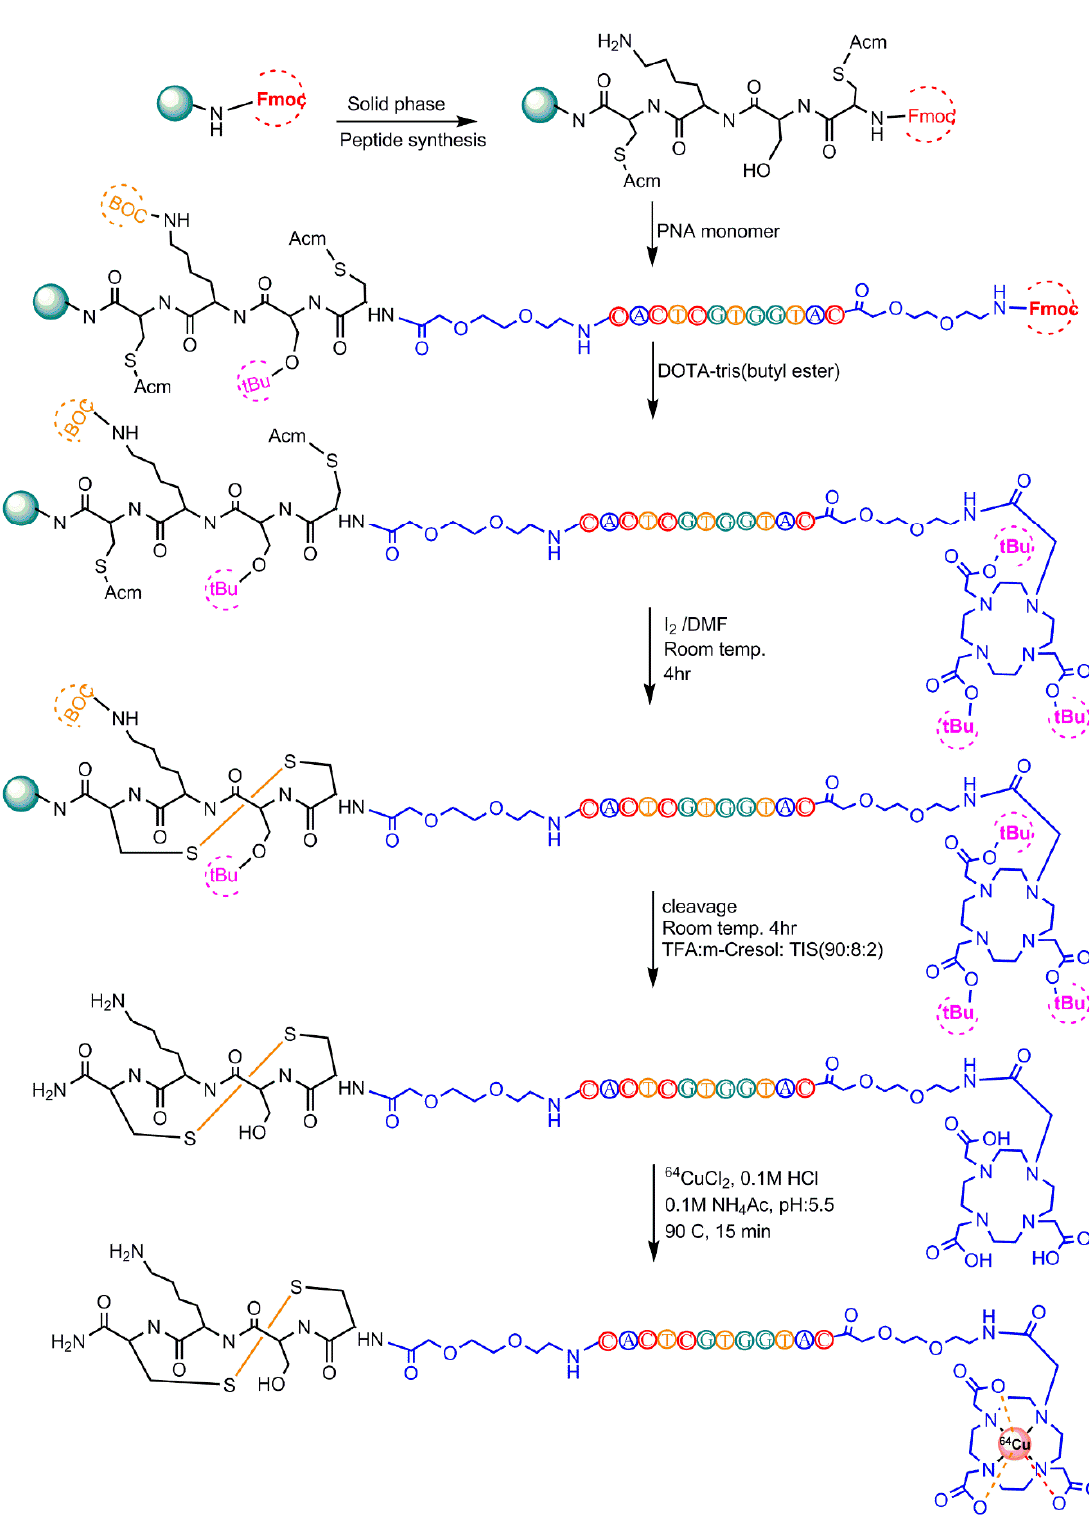
Figure 16. 64 Cu ‐ radiolabeling steps of peptide nucleic acid. Figure 16. 64 Cu-radiolabeling steps of peptide nucleic